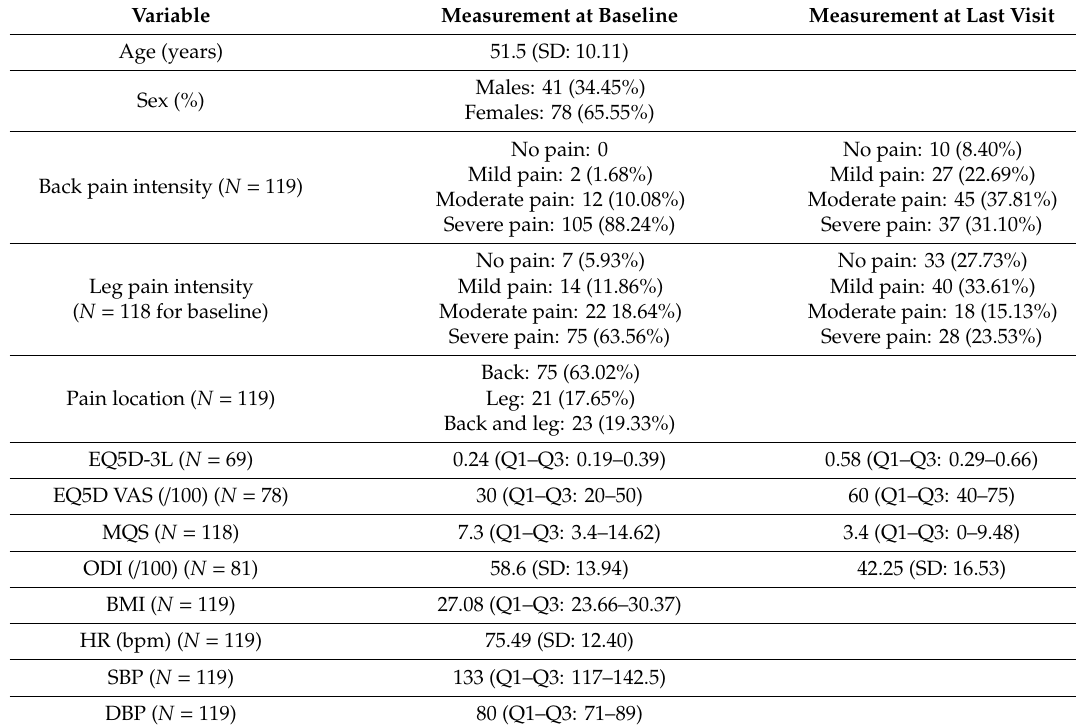
Table 1. Patient